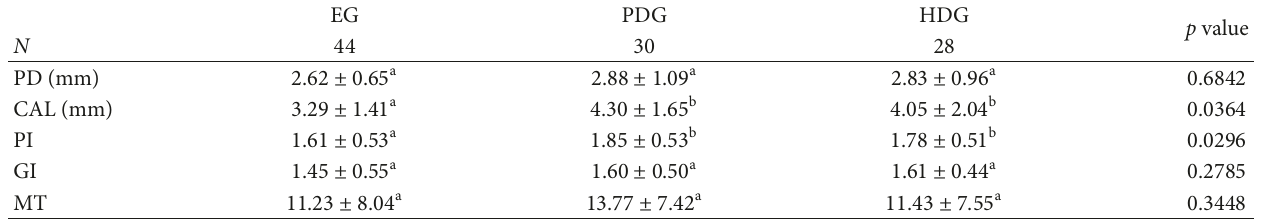
Table 2: Distribution and comparison of the periodontal parameters according to study groups (mean ± standard